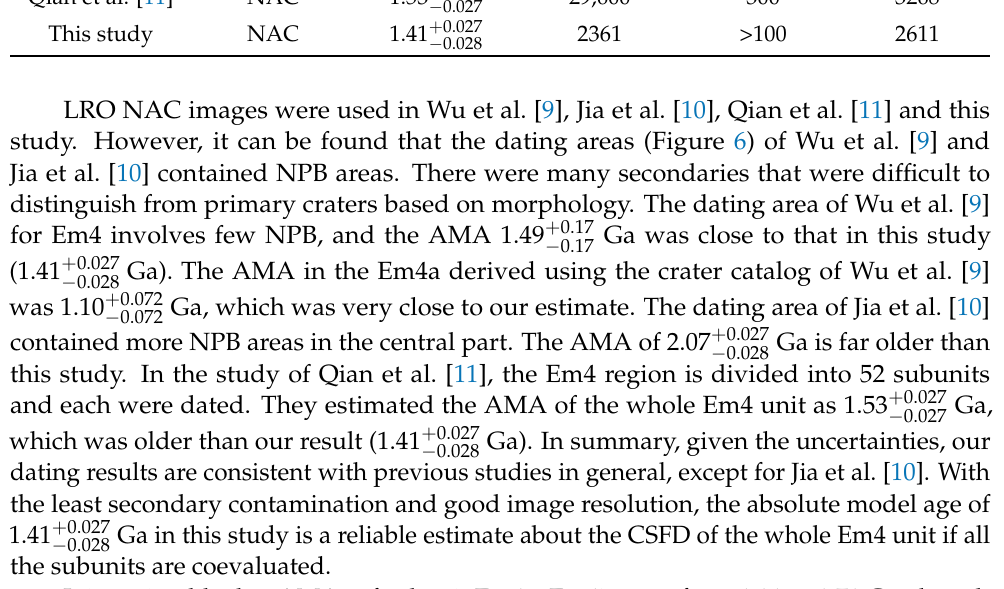
Crater Mapping Image